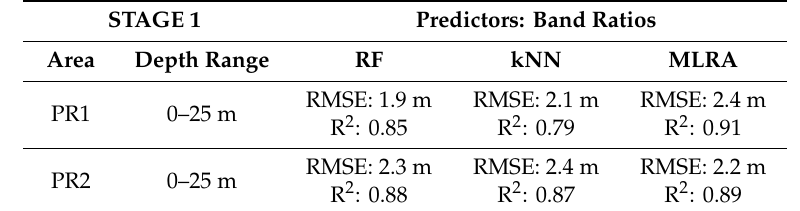
Table 2. Bathymetry prediction accuracy (RMSE and correlation coe ffi cient R 2 with reference bathymetry) for stage 1.